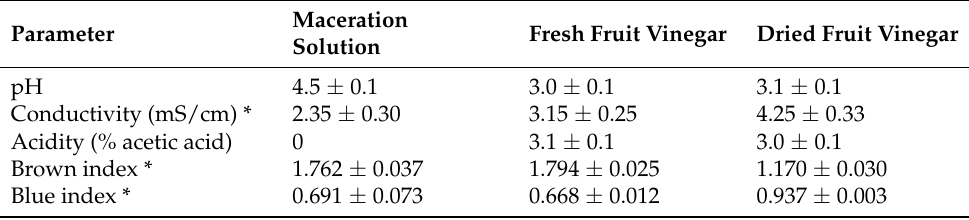
Table 3. Physiochemical properties of jaboticaba vinegar from fresh and dried